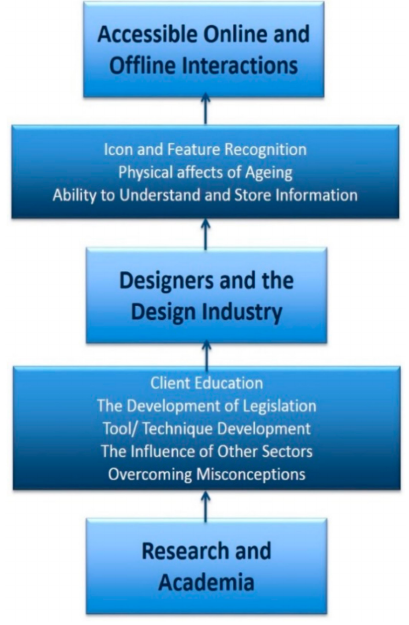
Figure 2. Conceptual